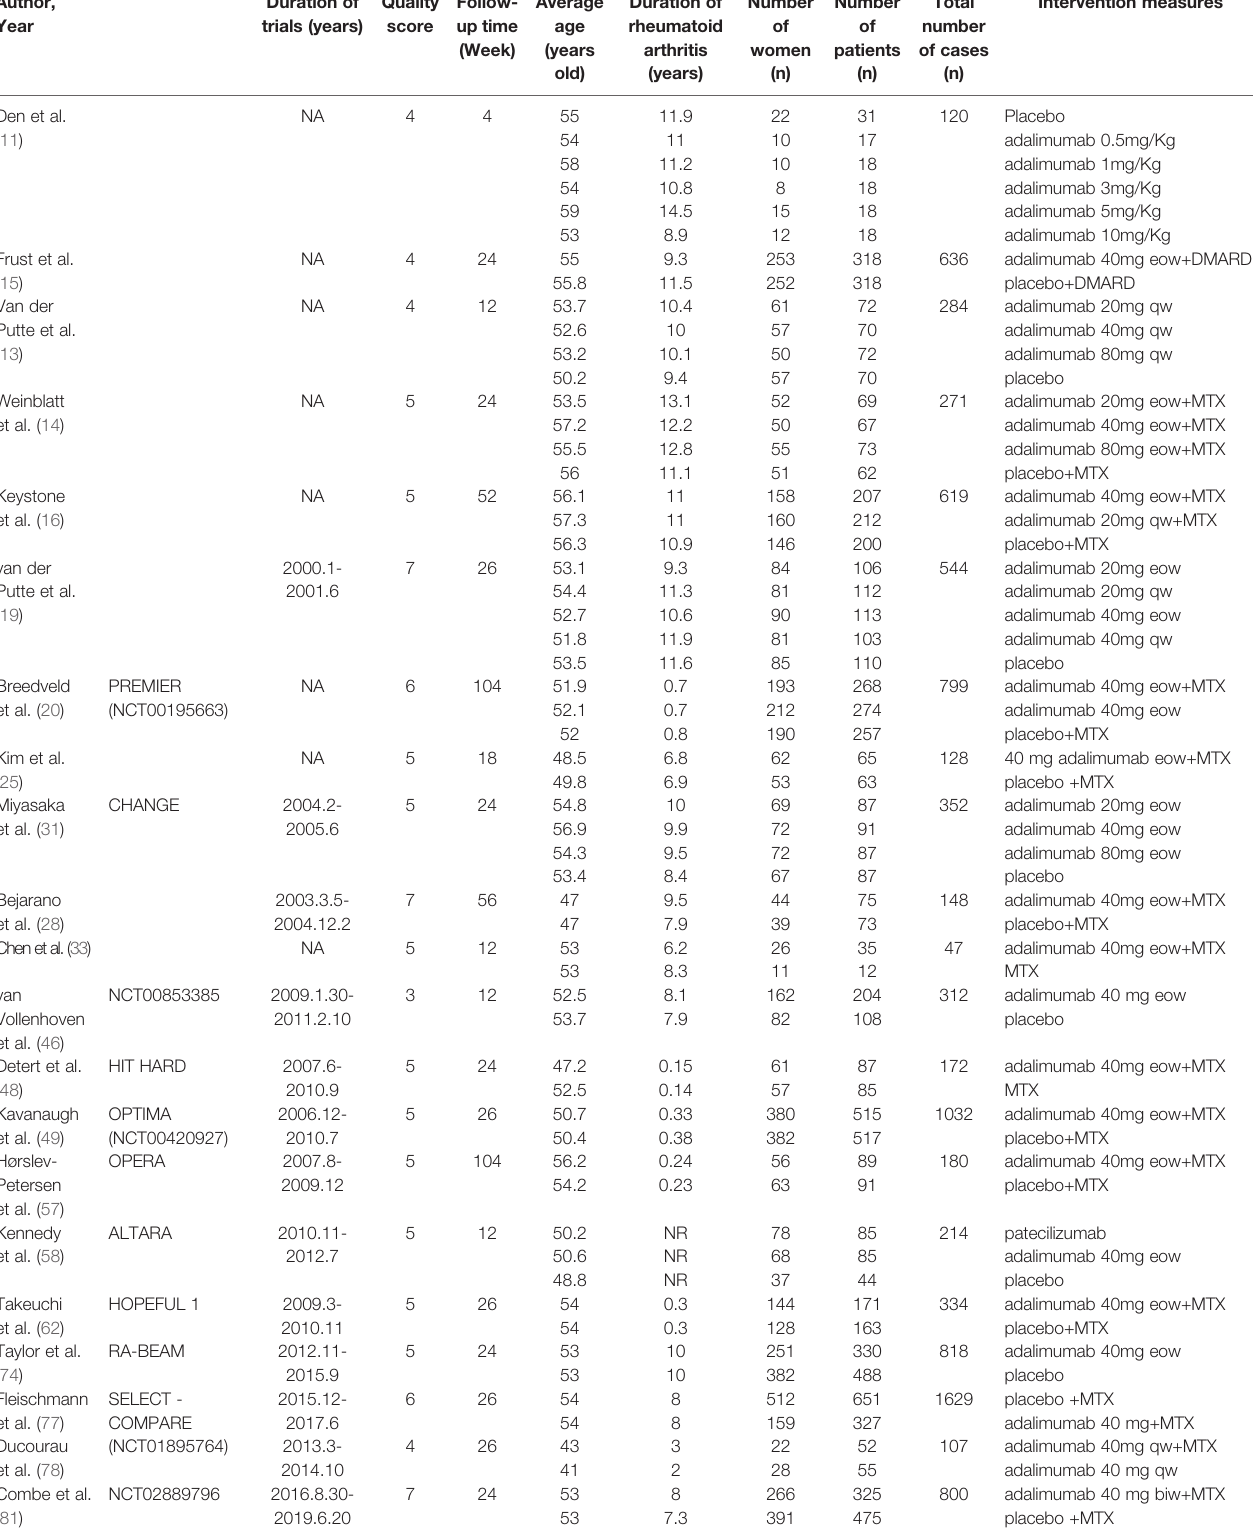
TABLE 1 | Characteristics of included